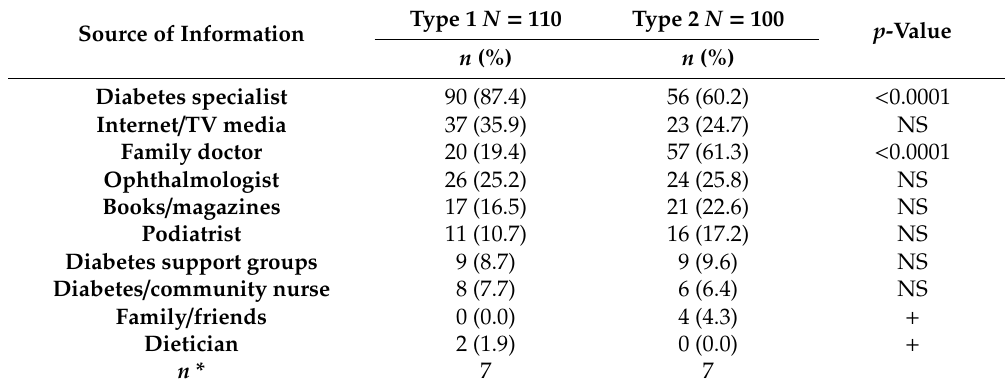
Table 4. Participants’ principal source of diabetes-related